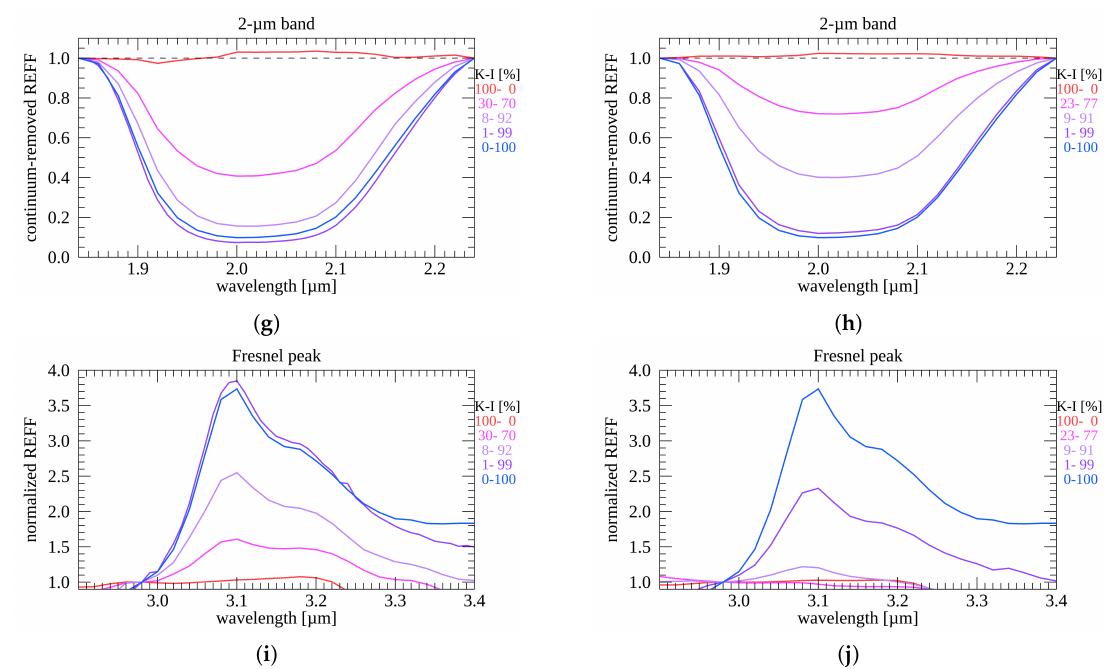
Figure 4. Water-ice-related absorption features and Fresnel peak for water ice–kerite 45–63 ( left panels: a , c , e , g , i ) and water ice–kerite < 25 ( right panels: b , d , f , h , j ) intimate mixtures. The name of the monitored feature is indicated in the corresponding panel title. Absorption bands are plotted after continuum-removal (the black dashed line in each plot indicates the continuum-removed baseline), while the Fresnel peak region is shown after normalization at 2.98 µ m. Kerite (K) and water ice (I) mass fractions are indicated.